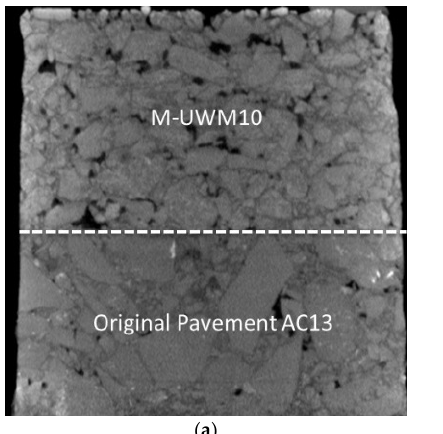
Figure 9. The scanning images for cored sample from M ‐ UWM10 pavement: ( a ) front view for cored sample; ( b ) the interface between wearing course with M ‐ UWM10 and sub ‐ layer with AC13.